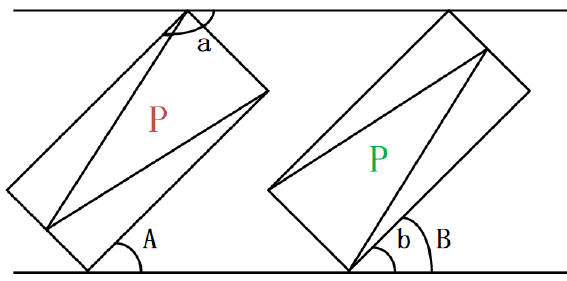
Figure 4. Angle interactivity.